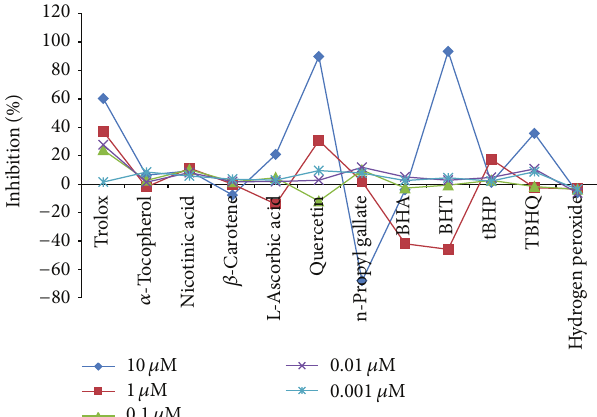
Figure 6: Percent values with respect to control calculated on the basis of time to half maximum of the kinetic